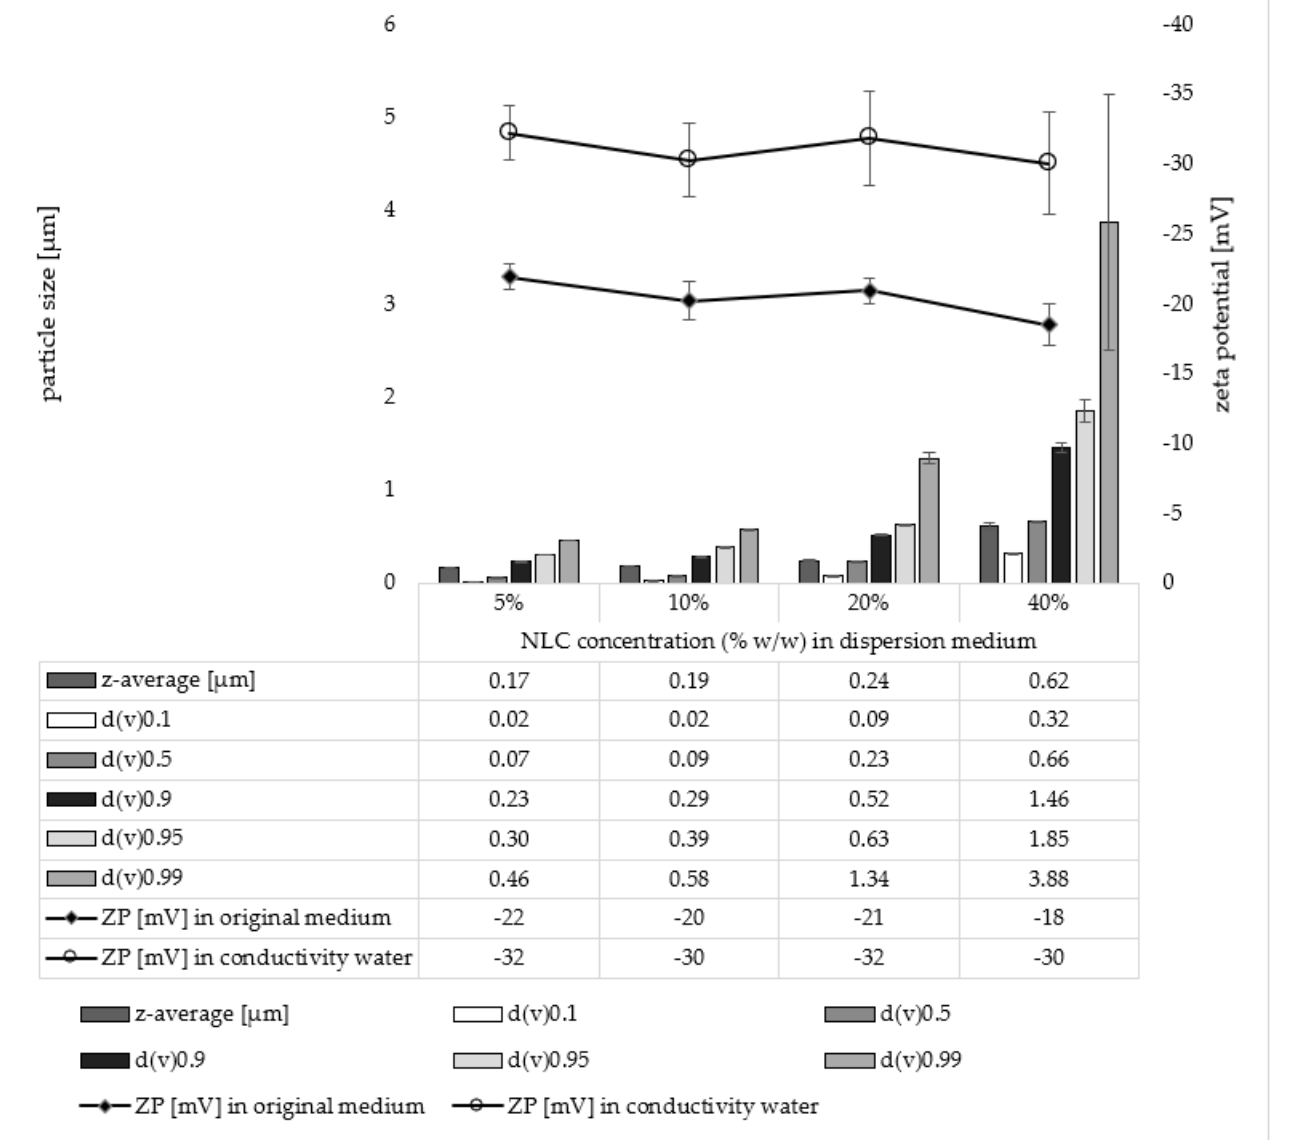
Figure 5. Influence of lipid content of NLC on particle size and zeta potential (ZP) of the NLC formulations. The particle size was assessed with dynamic light scattering which yields the hydrodynamic diameter (z-average). Laser diffraction was used to determine the volume-based size distribution of the particle dispersions. The obtained median volumetric diameters d(v)0.1–d(v)0.99 (µm) represent the percentage of the volume of the particles within the dispersion that are equal or below the given size. Zeta potentials (mV) were analysed in the original medium and in conductivity water, respectively.